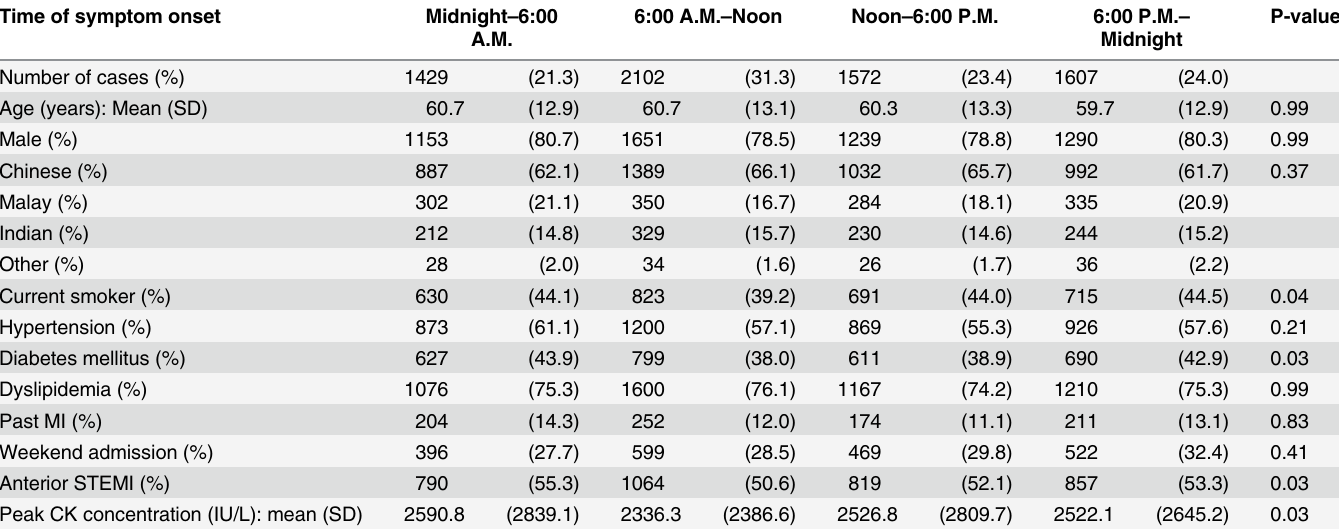
Table 1. Baseline characteristics of